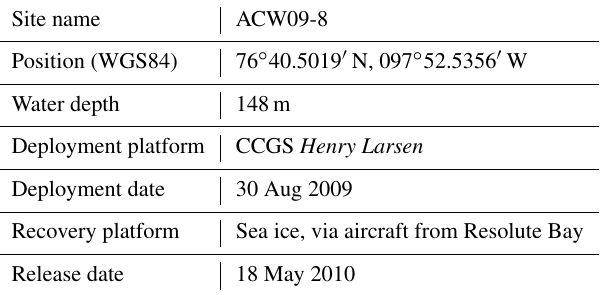
Table 1. Oceanographic mooring in the Penny Strait.